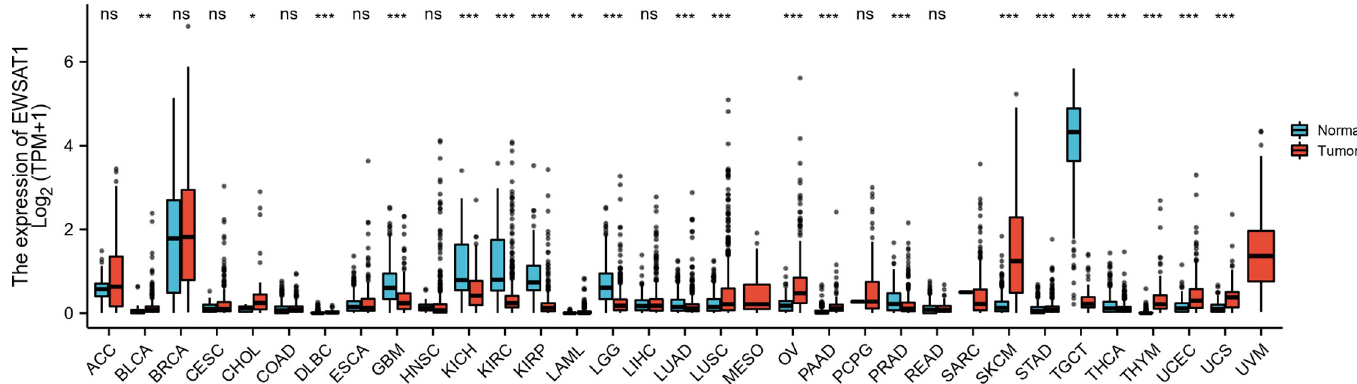
Fig 5. Expressions of EWSAT1 in tissues of normal and pancancer. Wilcoxon rank sum test: no significance (ns), p � 0.05; � , p < 0.05; �� , p < 0.01; ��� , p <